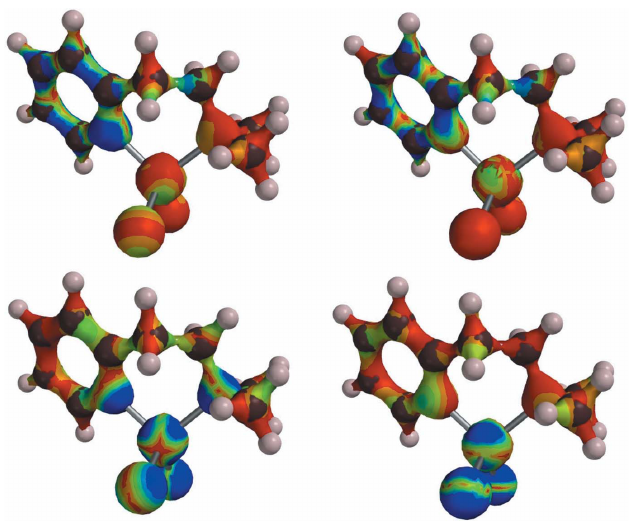
Figure 7 Wavefunction density surface maps of MOs involved in several of the visible-NIR transitions in a CoN 2 Cl 2 moiety of Co 2 (Ppz)Cl 4 , modelled with a 2-(dimethylaminoethyl)pyridine ligand. Lower left and right: originating HOMO( (cid:2) 3), HOMO( (cid:2) 4), respectively; upper left and right, the receiving LUMO and LUMO(+1), respectively. Blue indicates highest density. Note the translation of wavefunction density from the CoCl 2 or CoN 2 Cl 2 unit to the pyridine ring in the